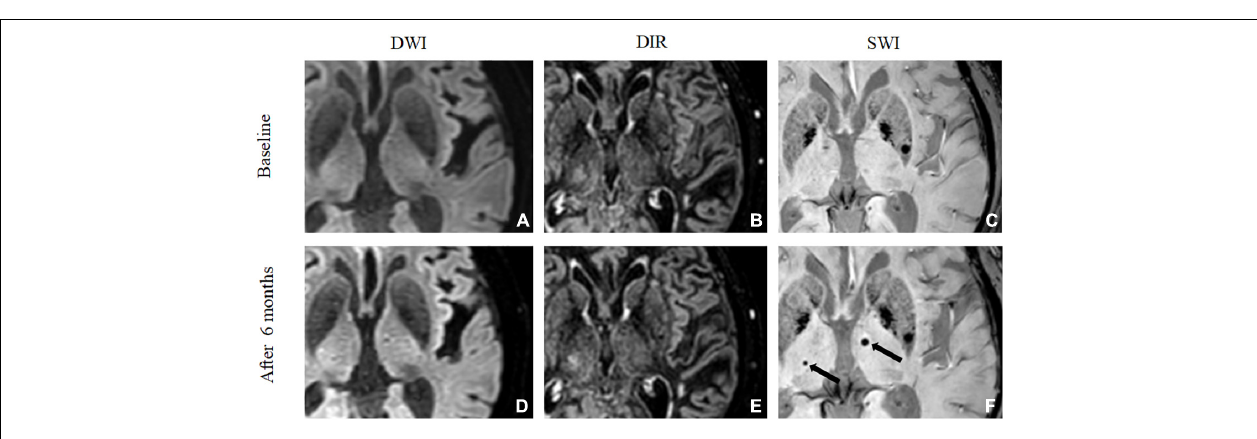
Frontiers in Cellular Neuroscience |